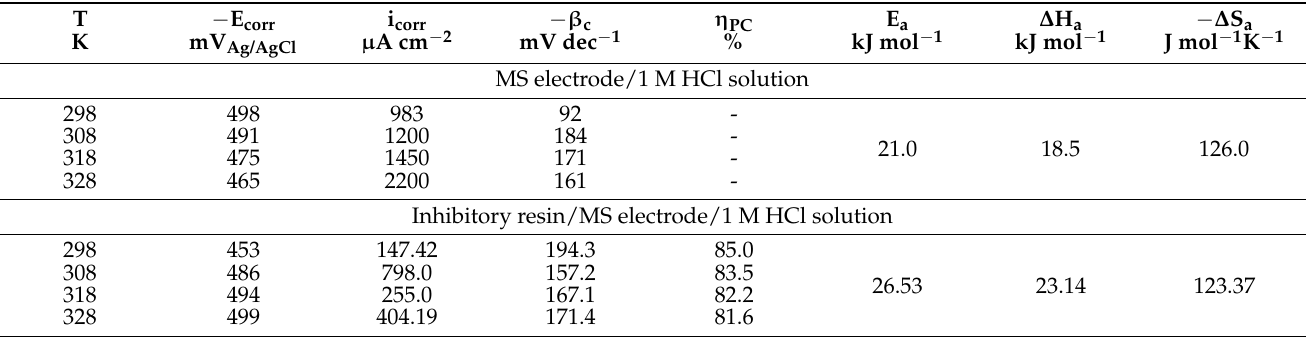
Figure 9. PDP curves of MS electrode in 1 M HCl solution, both unprotected and protected with 10 − 3 M of TGP at varying temperatures. Table 4. PDP and thermodynamic parameters of MS in 1 M HCl medium, both unprotected and protected with 10 − 3 M of TGP at 298, 308, 318 and 328